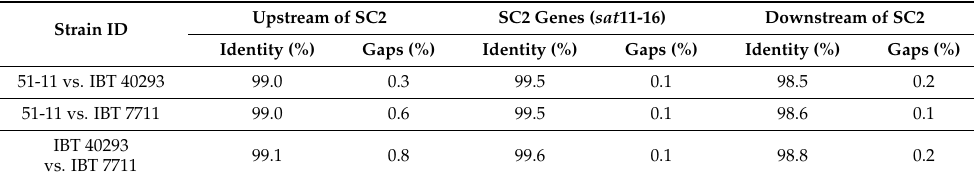
Table 5. Comparison of the satratoxin cluster 2 (SC2)-containing scaffolds (51-11: scaffold 111, IBT 7711: 1258, IBT 40293: